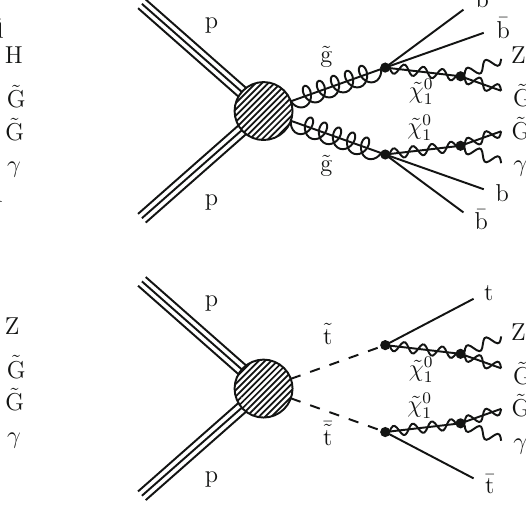
Fig. 1 Example diagrams depicting the simplified models used, which are defined in the text. The top left diagram depicts the T5qqqqHG model, the top right diagram depicts the T5bbbbZG model, the bottom left diagram depicts the T5ttttZG model, and the bottom right depicts the T6ttZG